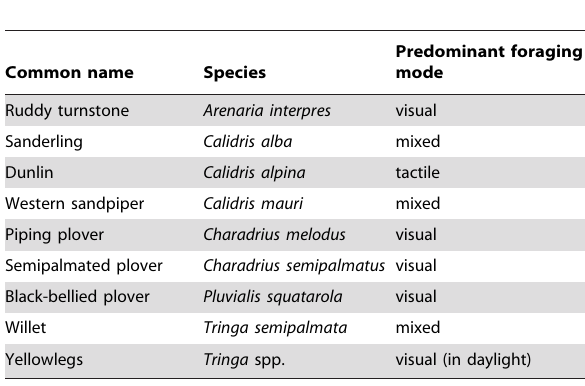
Table 3. Predominant foraging modes of all observed shorebird